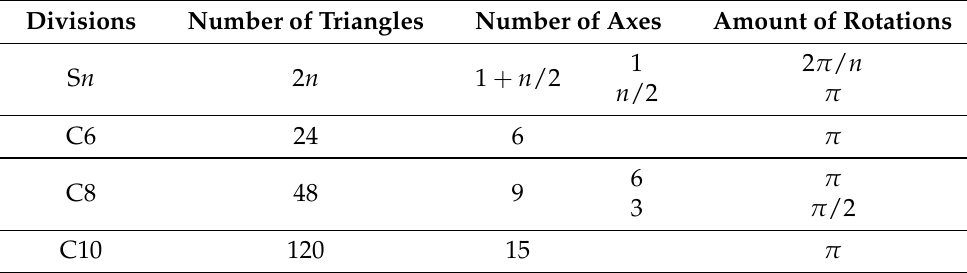
Table 1. Rotational properties of SphereHarmonic (triangles and